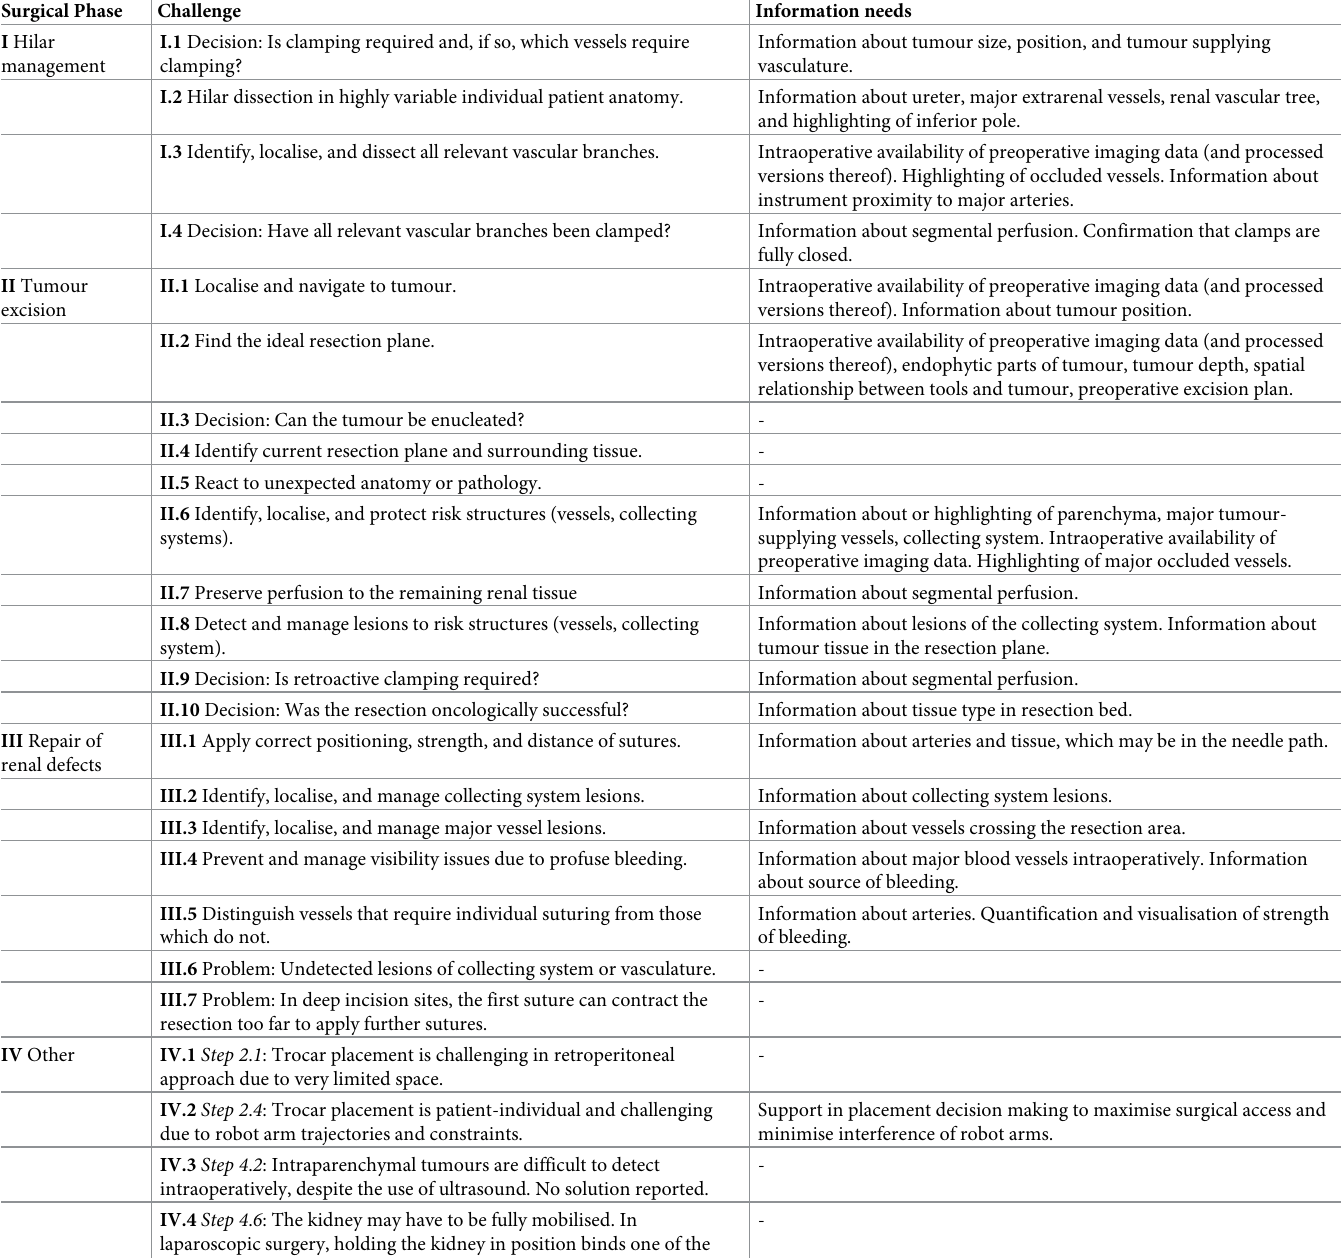
Table 2. Challenges and information needs for most risky and challenging surgical phases. Surgical Phase